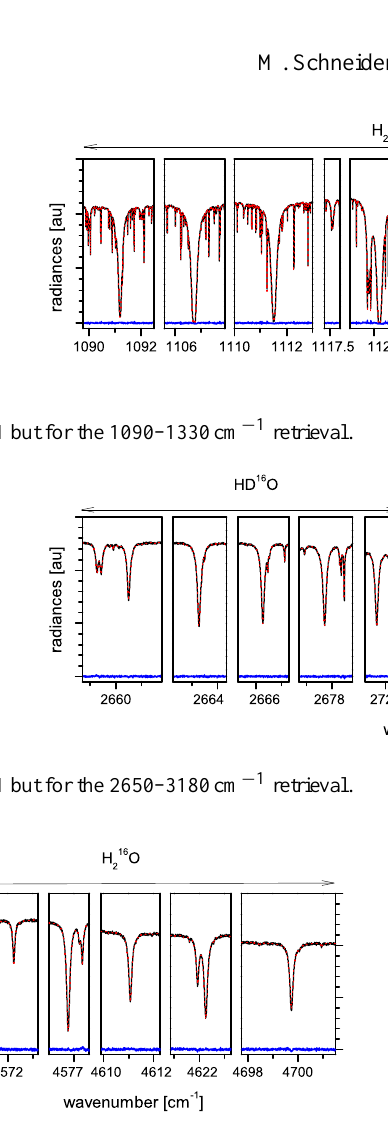
Fig. 4. Same as Fig. 1 but for the 4560–4710cm − 1 Fig. 4. Same as Fig. 1 but for the 4560 - 4710 cm − 1 retrieval. Fig. 4. Same as Fig. 1 but for the 4560 - 4710 cm − 1 retrieval. et al. (2010c). Fig. 4. Same as Fig. 1 but for the 4560 - 4710 cm − 1 retrieval. et al. (2010c). et al. (2010c).